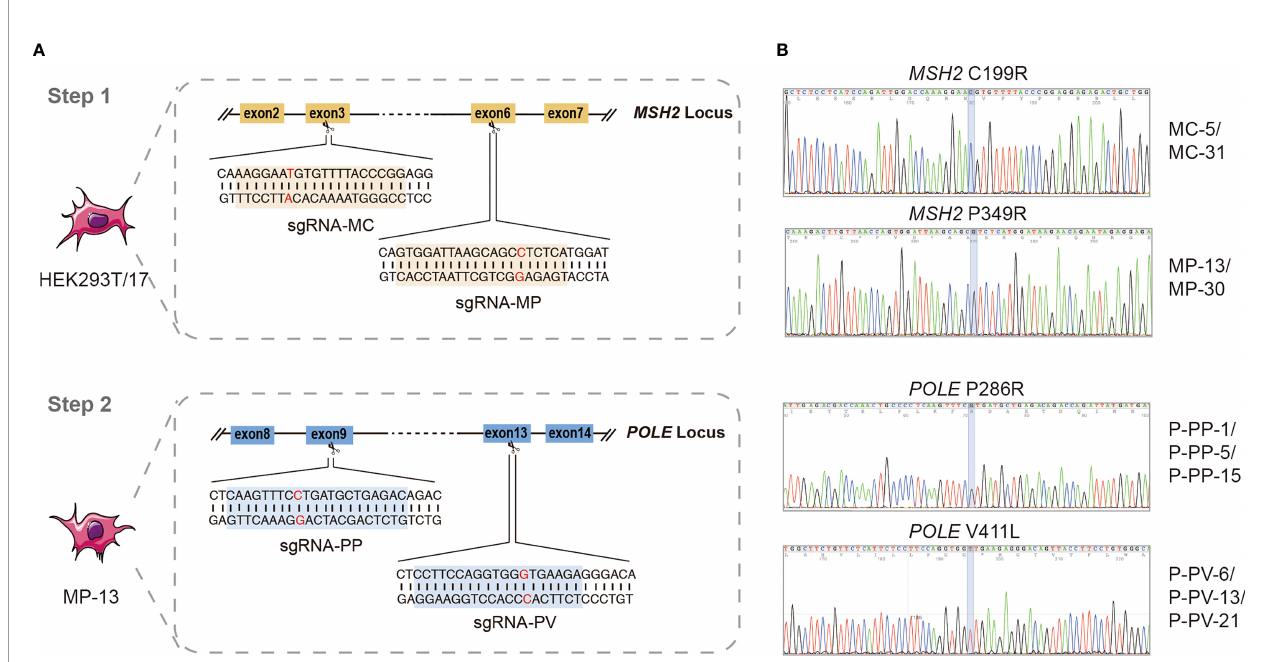
FIGURE 1 | Generation of novel cell lines co-existing with MSH2 and POLE variants by CRISPR/Cas9 system. (A) Schematic of the two-stage strategy for generating novel cell lines co-existing with MSH2 and POLE variant. The sequence of sgRNAs for MSH2 C199R (sgRNA-MC) and MSH2 P349R (sgRNA-MP) are marked in yellow and sequence of sgRNAs for POLE P286R (sgRNA-PP) and POLE V411L (sgRNA-PV) are marked in blue. (B) Sequences of the PCR products showing the correct mutations of positive clones. 4 different MSH2 mut / POLE wt cell lines and 6 different MSH2 mut / POLE mut cell lines were ultimately